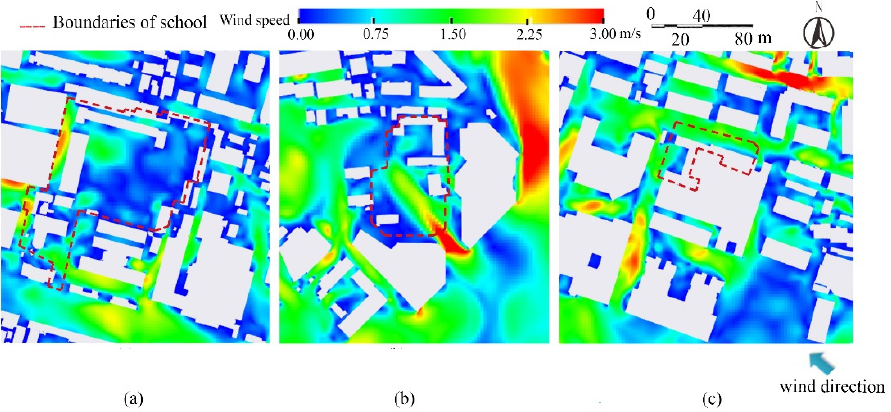
Figure 5. Wind speed distributions at the pedestrian level in three primary schools in summer in the 1990s: ( a ) Changjiang Road Primary School; ( b ) Chibi Road Primary School (Shanxi Road Campus); ( c ) Jianye Road Primary School.